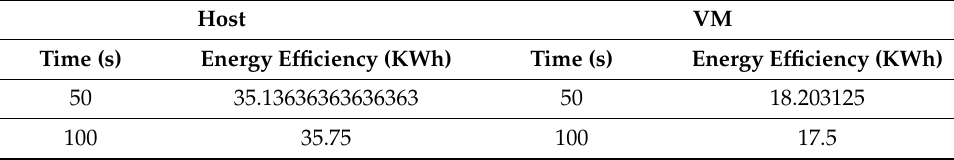
Table 3. Energy efficiency values for host and